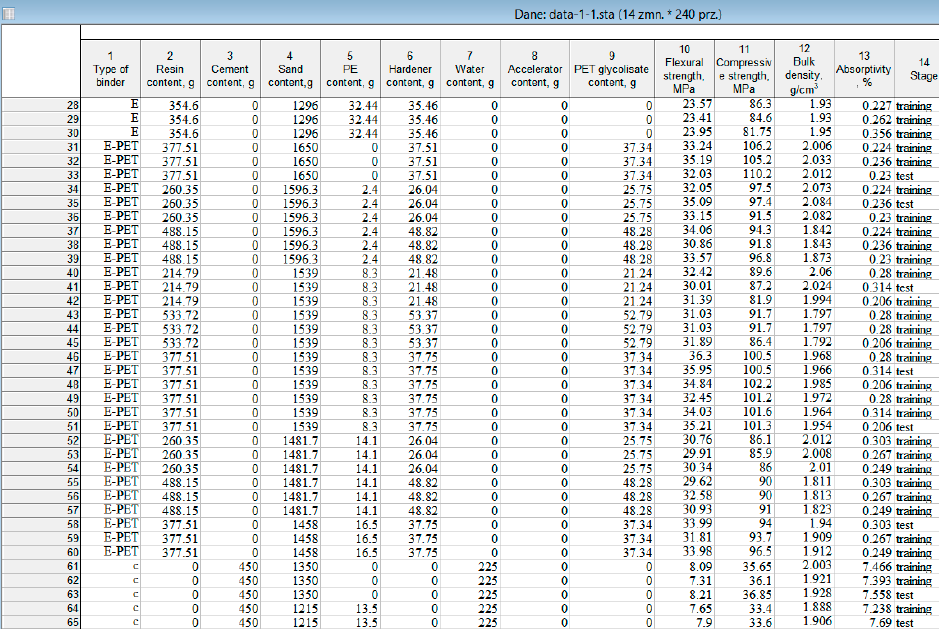
Figure 3. Fragment of the experimental database.